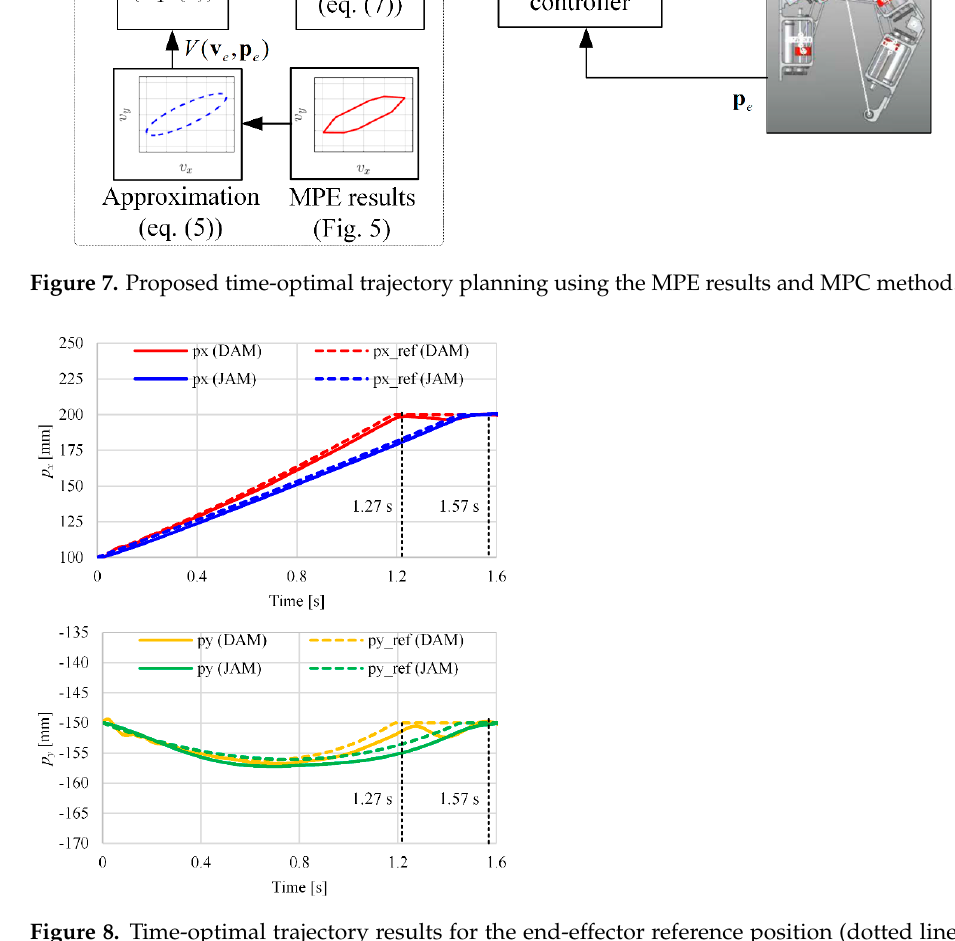
Figure 7. Proposed time-optimal trajectory planning using the MPE results and MPC method.